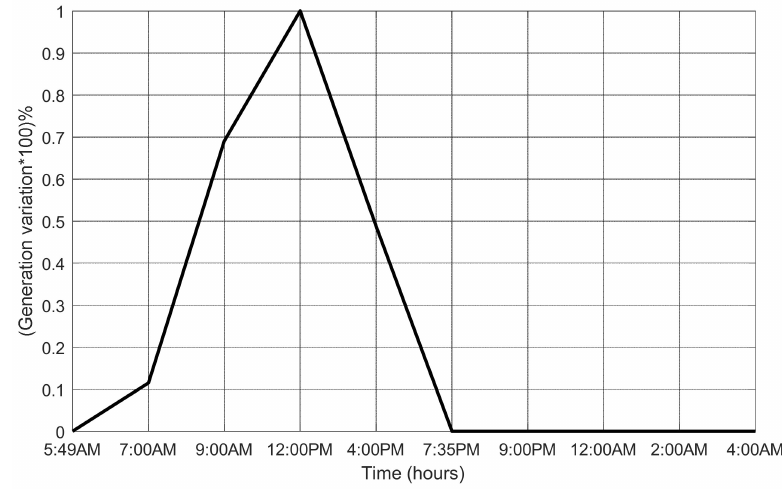
Figure 6. PV generator factor variations in the time domain.